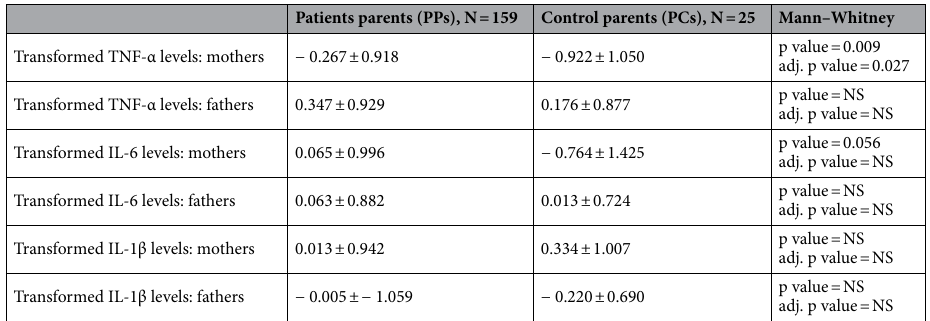
Table 1. Transformed cytokine levels in the parents of the patients’ group vs. the parents of the control group.